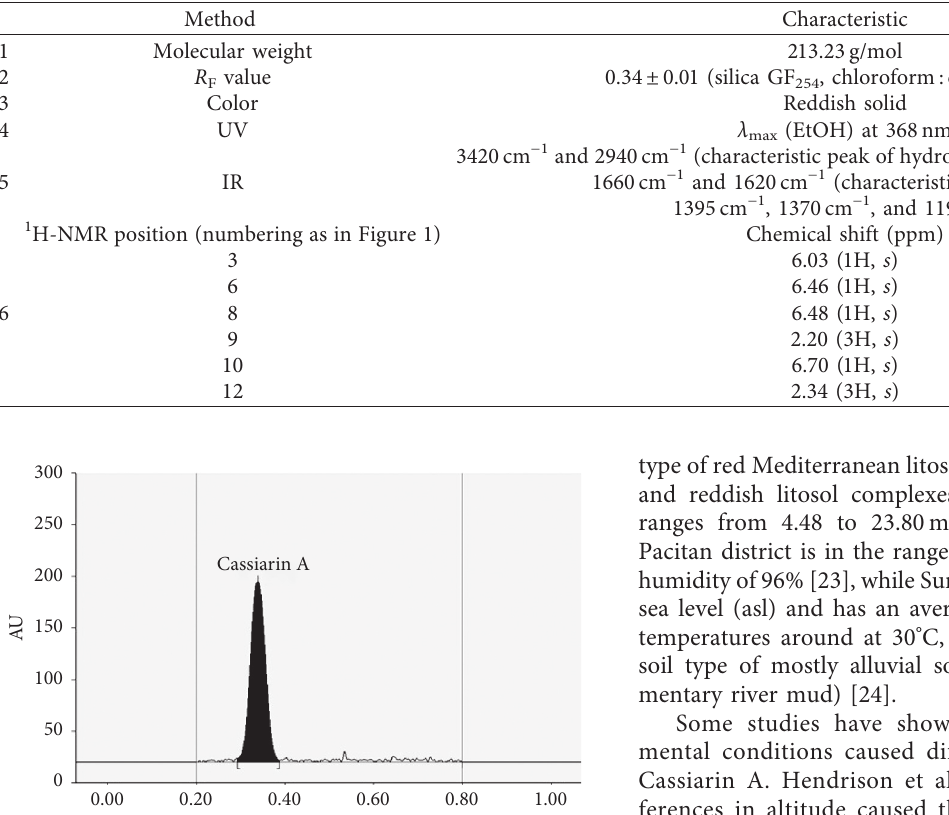
Table 1: Characteristics of Cassiarin A [18].